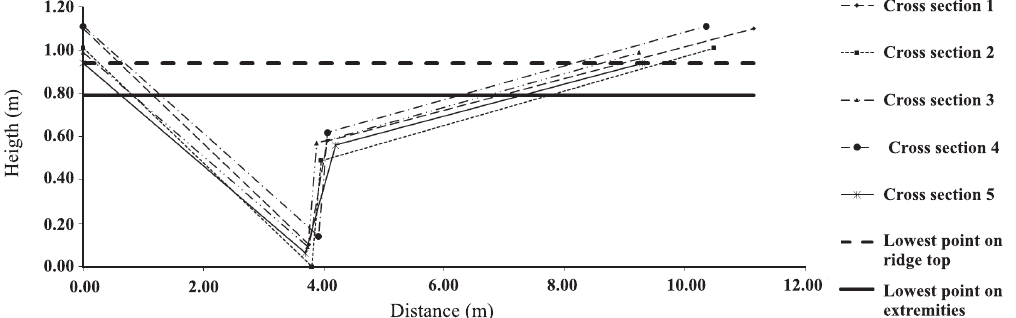
figure 8. Profile of terrace 3 cross section after simulation of raising the ridge height and closing the terrace ends.